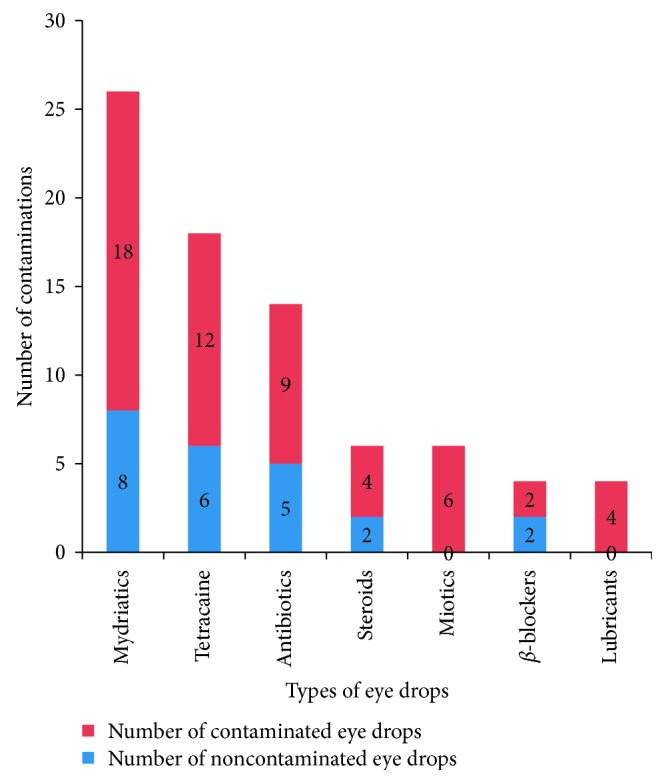
Types and number of contaminated commonly used eye drops contamination at Department of Ophthalmology, Jimma University from June to December 2015.